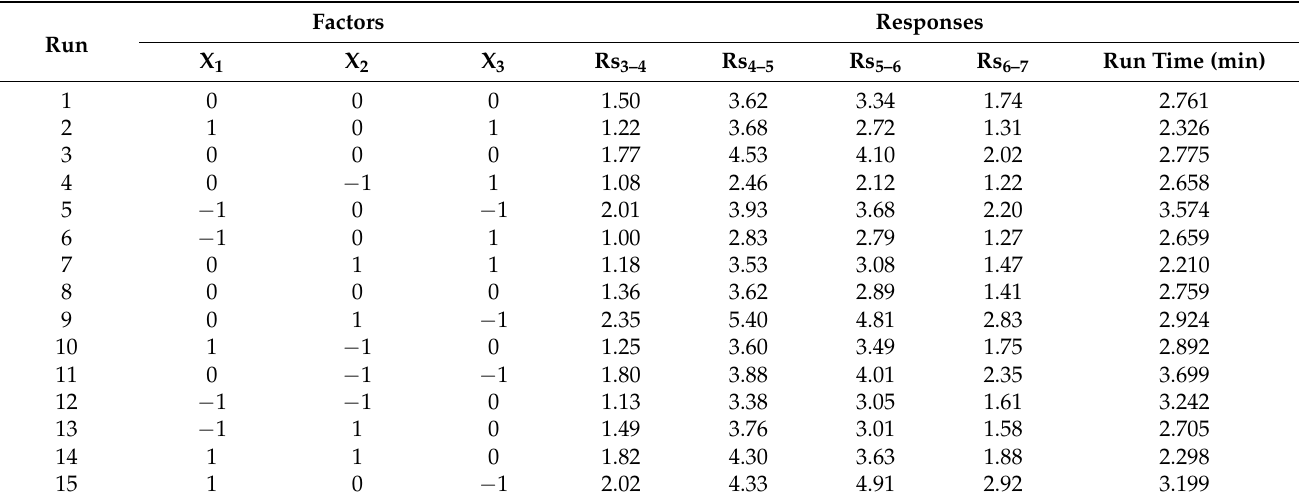
Table 1. Box–Behnken design matrix and experimental values obtained for resolutions and run time. Run